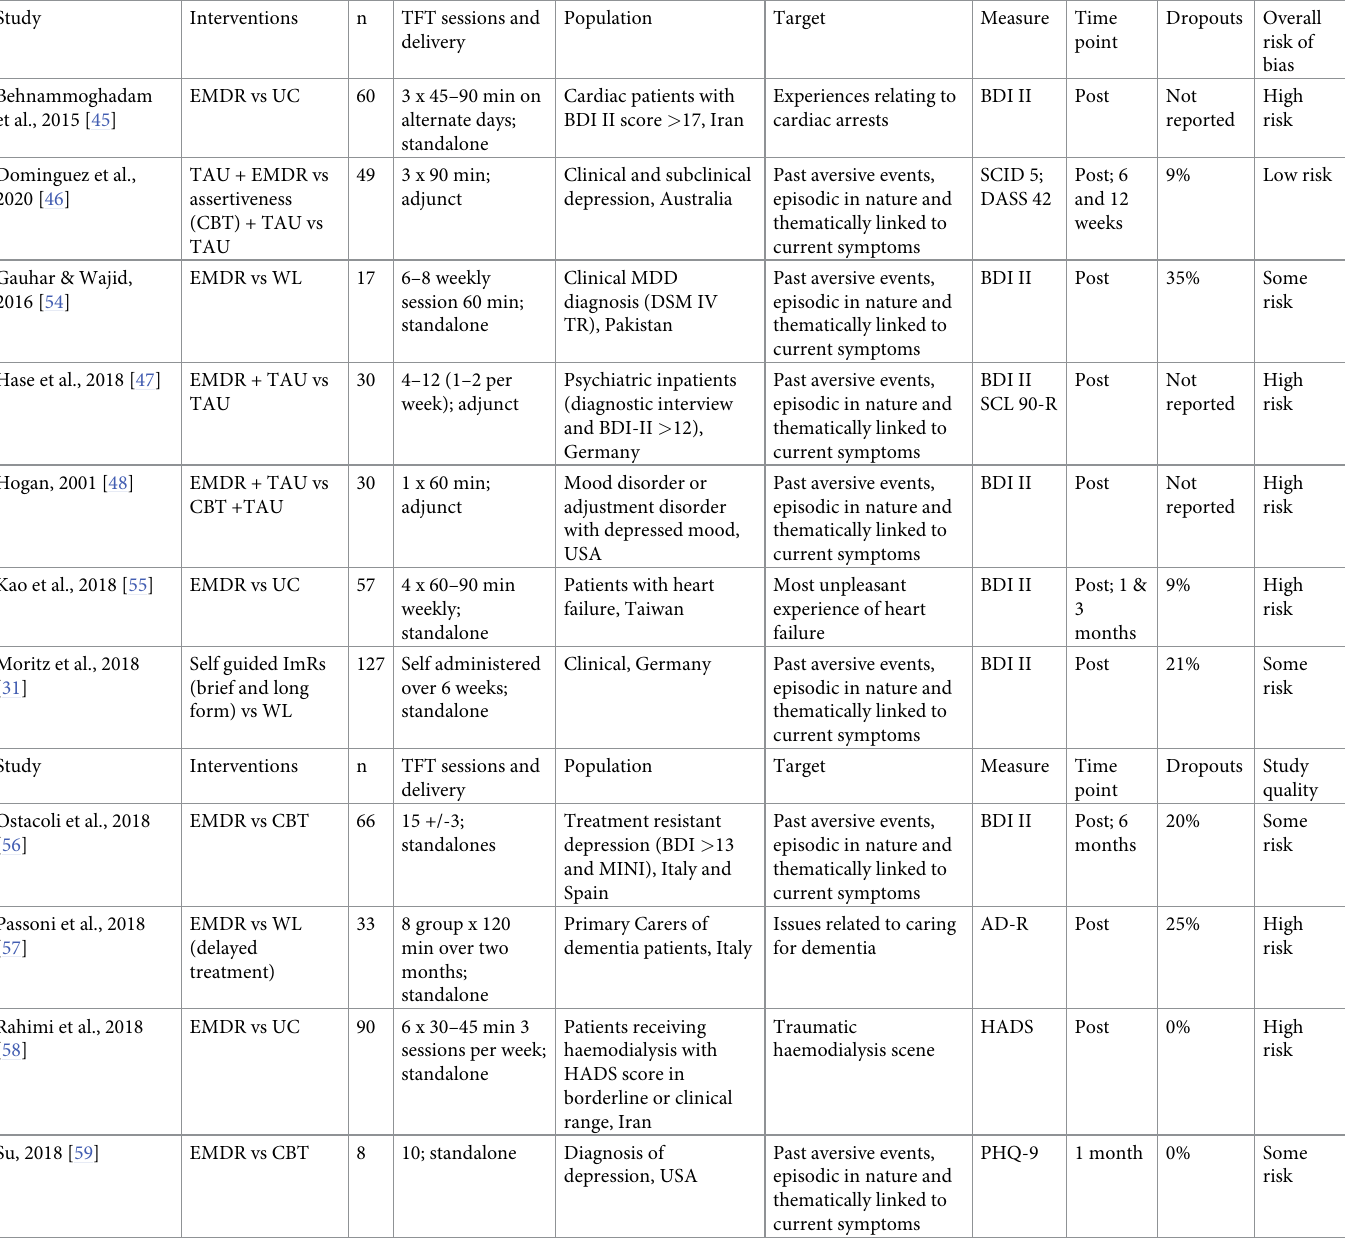
Table 1. Description of included